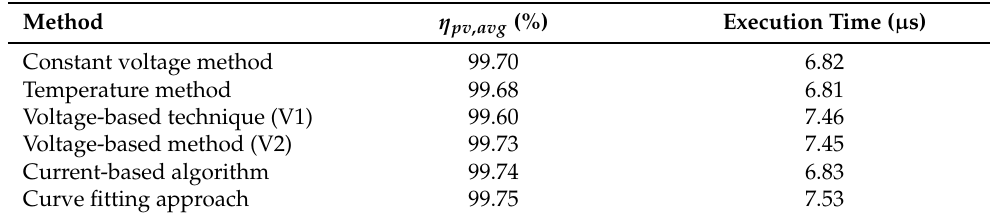
Figure 4. The steady-state performance of model-based MPPT methods at 600 W/m 2 radiation. ( a ) Constant voltage method, ( b ) temperature method, ( c ) voltage-based method (V1), ( d ) voltage- based technique (V2), ( e ) current-based algorithm, ( f ) curve fitting approach. Table 2. Average efficiencies and execution times of the model-based MPPT techniques at step change of